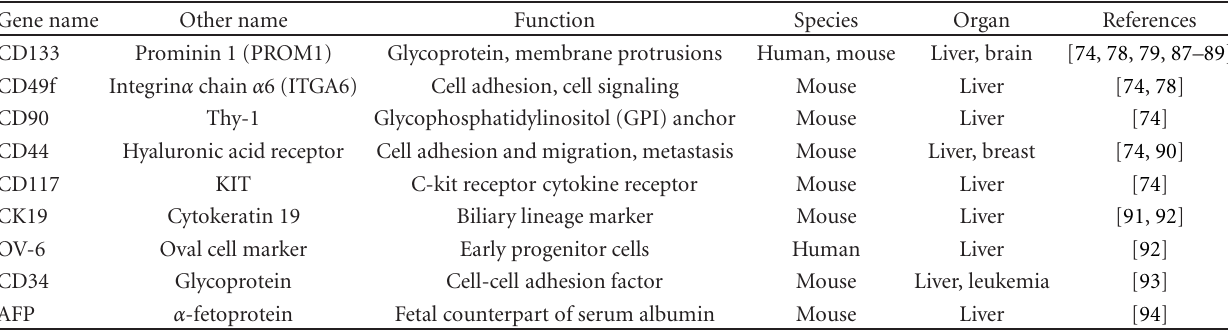
Table 1: Markers for liver cancer stem